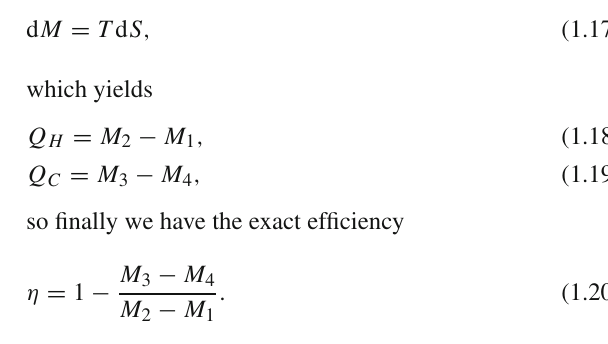
the heat capacity